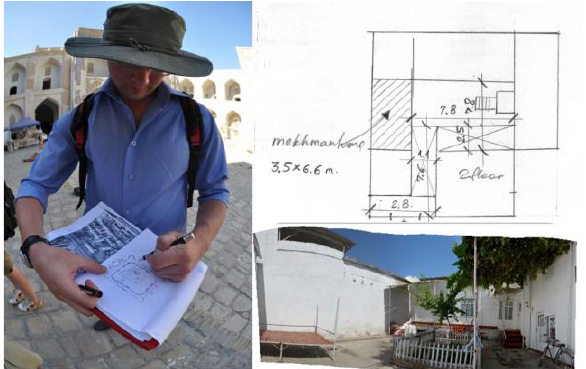
Figure 11. Survey during field work in Bukhara. © UNESCO Field survey project